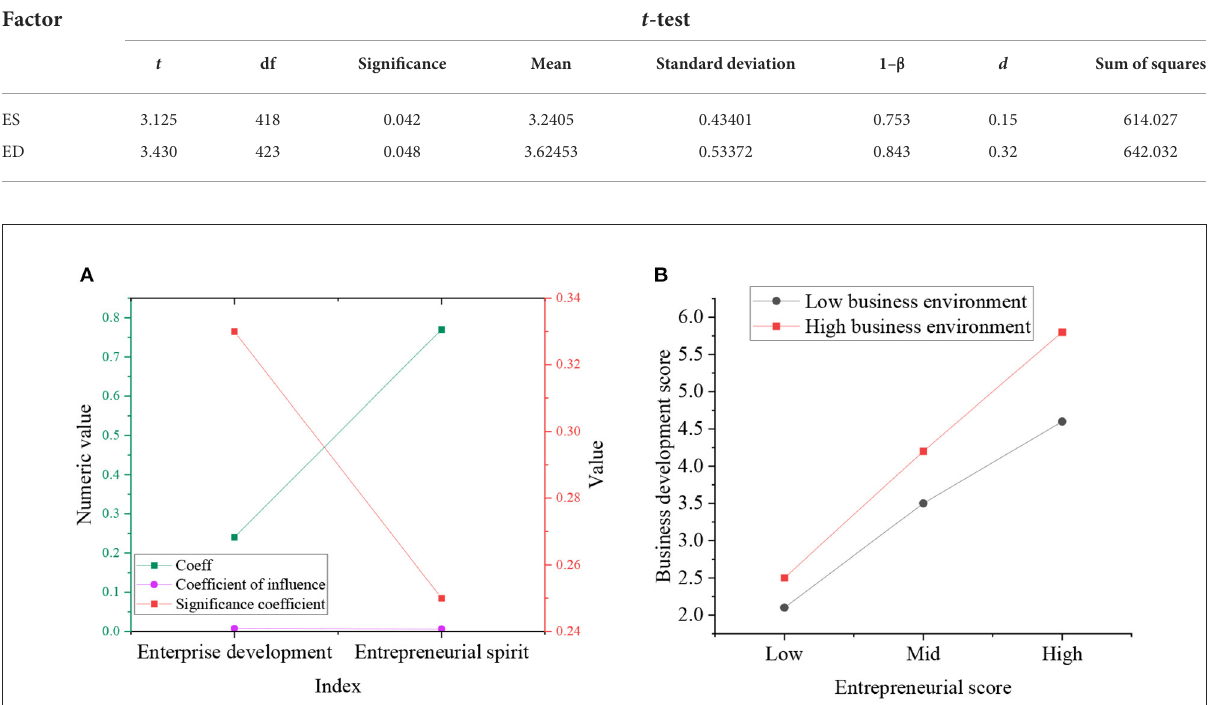
The independent sample t -test results of ES and ED are